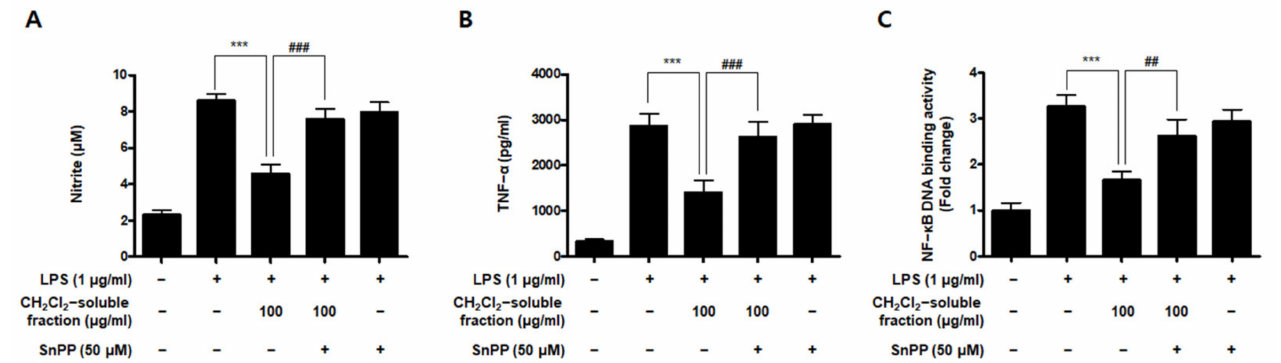
Figure 12. Effects of CH 2 Cl 2 -soluble fraction-induced Nrf2-mediated HO-1 expression on LPS-stimulated proinflammatory mediator production in BV2 cells. Cells were pretreated with the CH 2 Cl 2 -soluble fraction for 3 h with or without SnPP (50 µ M), and subsequently stimulated with LPS (1 µ g/mL) for 24 h. In the Materials and Methods section, the methods used for measurement of nitrite ( A ), TNF- α ( B ), and NF- κ B DNA-binding activity ( C ) are described in detail. Data are presented as the mean ± standard deviation for 3 independent experiments. *** p < 0.001, ## p < 0.01, and ### p < 0.001.